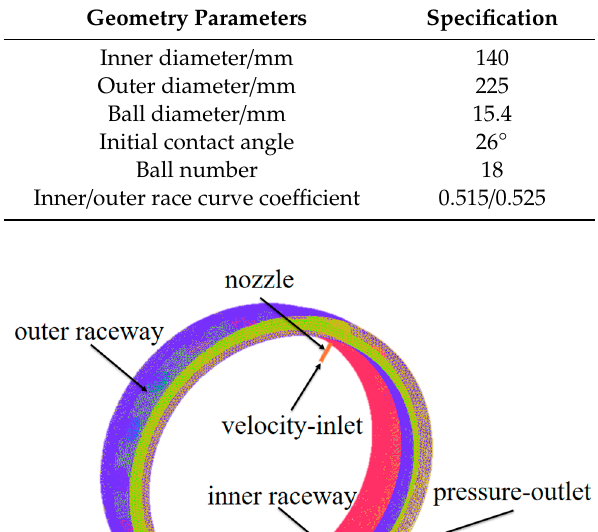
Figure 2. Computational mesh structure.